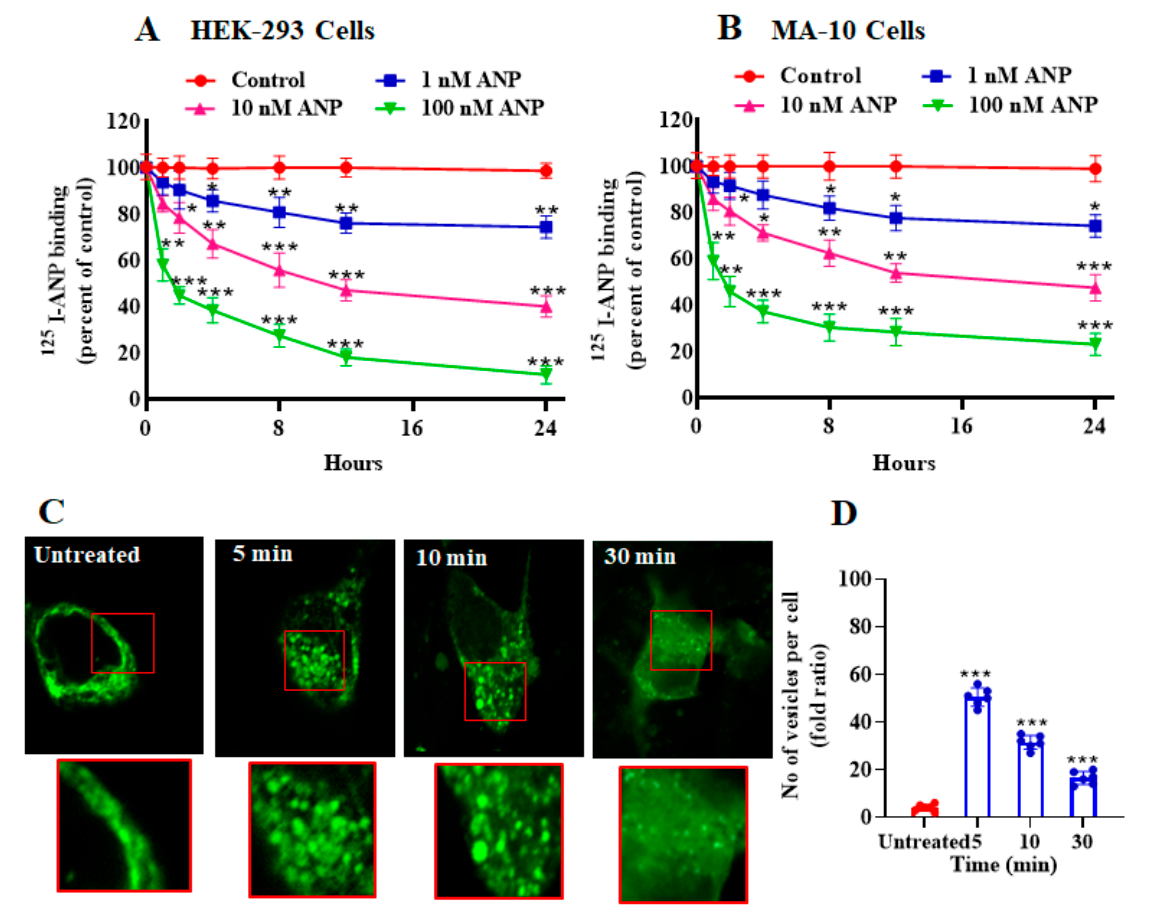
Figure 1. Effect of ANP pretreatment on 125 I-ANP binding and ANP-induced eGFP-NPRA internal- ization in stably expressing recombinant HEK-293 cells and endogenously expressing MA-10 cells. ( A , B ) Confluent HEK-293 cells and MA-10 cells were pretreated with varying concentrations of ANP for the indicated times at 37 ◦ C. Cells were transferred to 4 ◦ C and 125 I-ANP binding was done in assay medium containing 0.1% BSA as described under the Section 4 for 30 min at 4 ◦ C. Cells. ( C ) A series of single confocal plane images were taken from HEK-293 cells fixed with 4.0% formaldehyde to visualize the internalization of NPRA after stimulation by 100 nM ANP. The images of mid-focal planes were collected from 5–6 independent experiments. The magnified images of areas have been indicated in red squares. ( D ) The highlighted changes in the images have been quantified and scored. Values are expressed as means ± SE of 6–7 independent experiments. * p < 0.05, ** p < 0.01, *** p < 0.001 (untreated vs. drug-treated